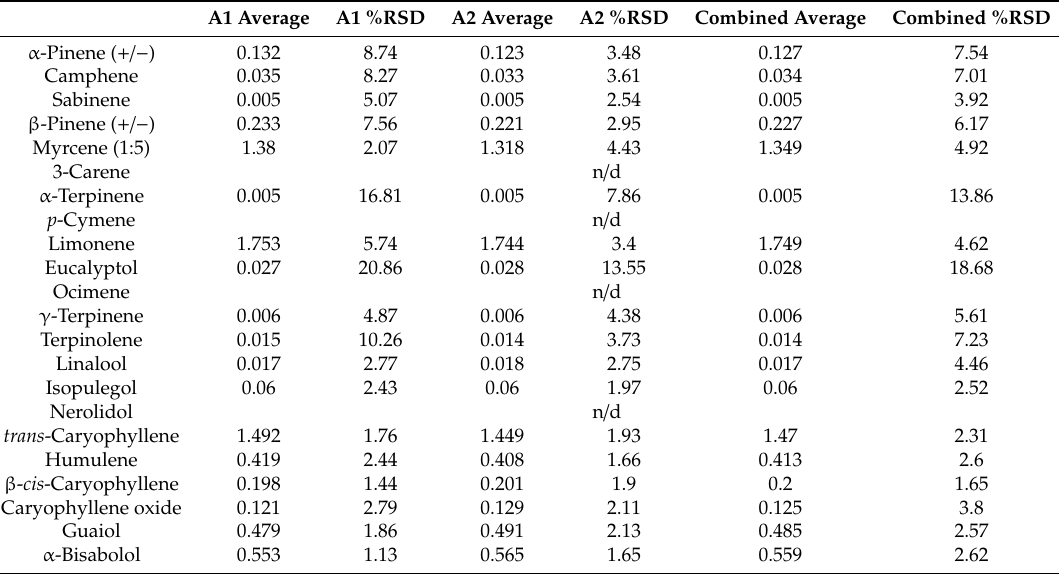
Table 4. Precision and intermediate precision results. Averages are expressed as µ g / g dry biomass. Compounds not detected in the biomass used are marked as n / d.